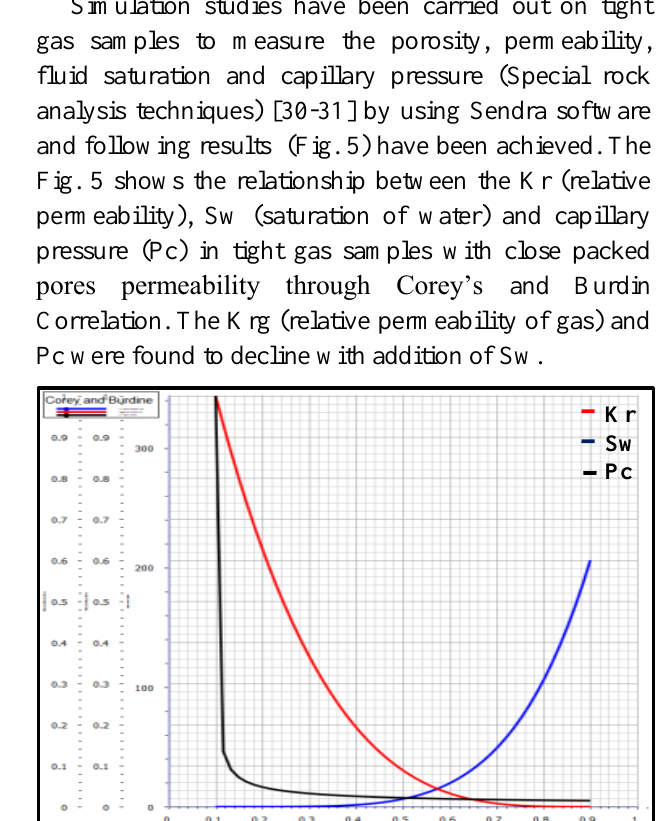
Fig. 5 . Relative permeability and water saturation relationship using Corey and Burdine